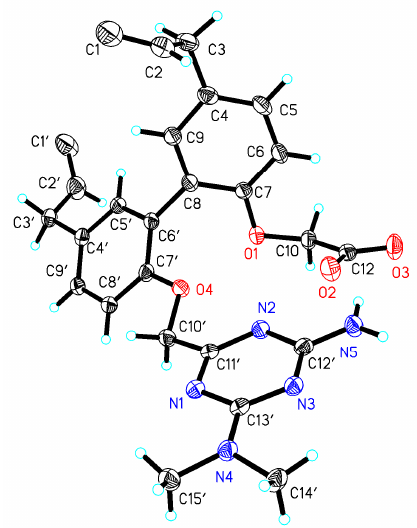
Figure 2. X-ray ORTEP (Oak Ridge Thermal Ellipsoid Plot) drawing of compound 1 .